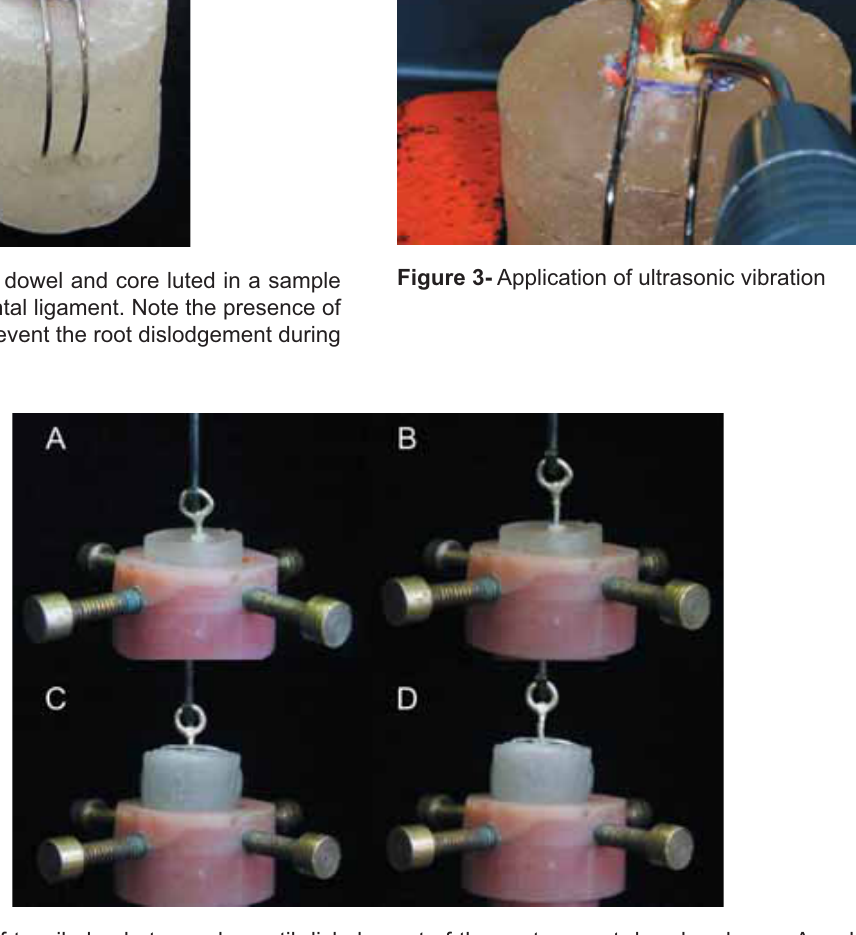
Figure 4- Application of tensile load at samples until dislodgment of the custom cast dowel and core. A and B - without simulated periodontal ligament; C and D - with simulated periodontal Table 1- Tensile strength means values in KgF (SD) necessary to dislodge the cast post-and-cores